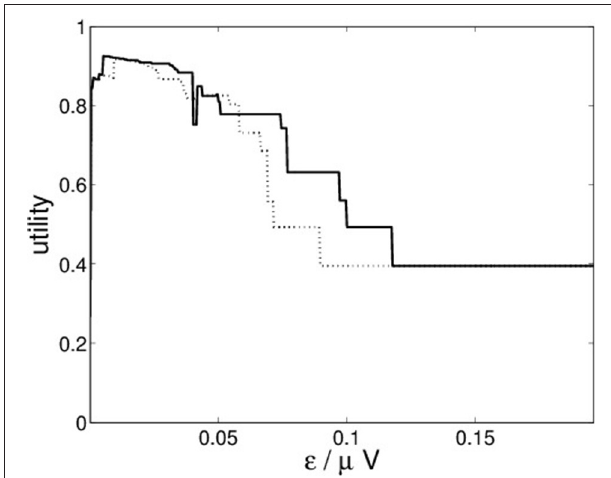
FIGURE 10 | RSA Markov utility functions for neural fields simulations for conditions (22-a) (solid) and (22-b) (dotted).